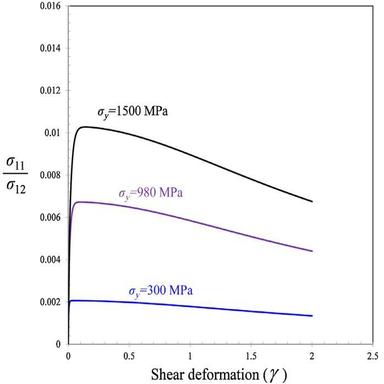
2. Development of normal stress in simple shear for an elastic-perfect plastic material with different yield strengths and a shear modulus of steel at 84 GPa. The normal stresses are equal-and-opposite such that σ σ 22 1 = − 1.